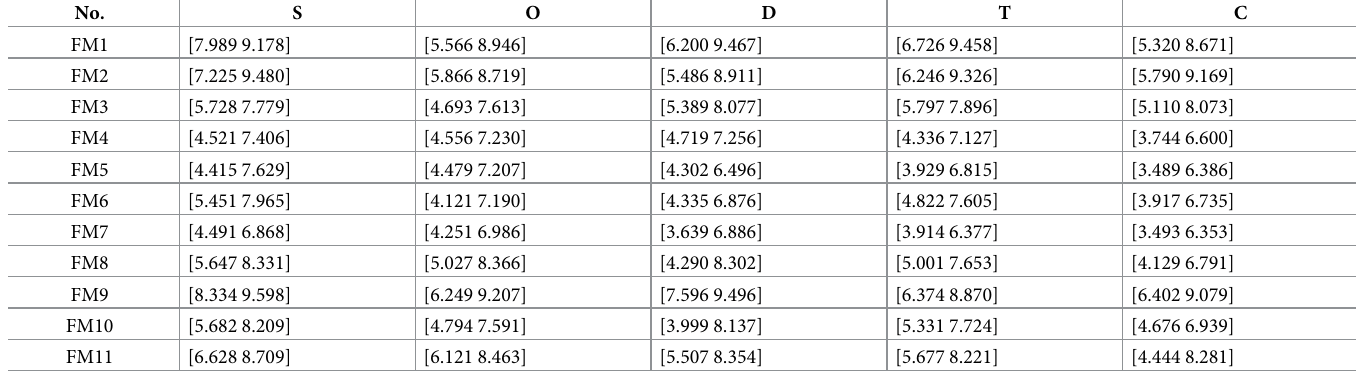
Table 5. The rough weighted normalized matrix of failure modes. Weighted Matrix